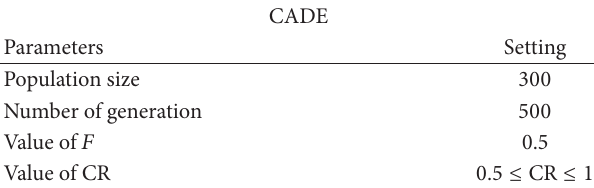
Figure 3: The flow diagram of the cultural algorithm. Table 1: Parameter used in